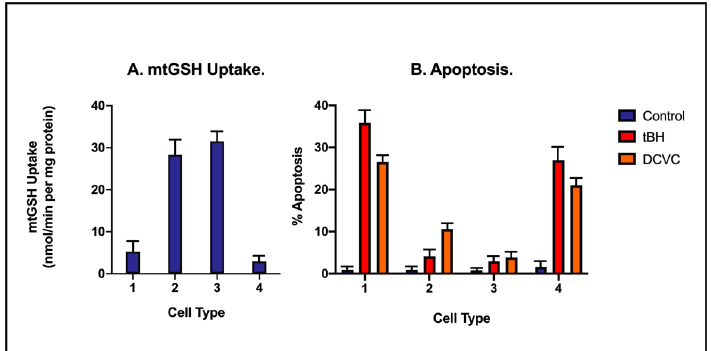
Figure 7. Impact of genetic modulation of mtGSH transporter expression in NRK-52E cells on mtGSH uptake and apoptosis caused by two mitochondrial toxicants. The cDNA for the rat kidney DIC was transiently overexpressed in NRK-52E cells (NRK-DIC = cell type 2), and the cDNA for either the normal OGC (NRK-OGC = cell type 3) and that of a double-cysteine mutant OGC with ~20% of normal activity (NRK-OGC-C221,224S = cell type 4) were stably expressed. Responses were compared to those of wild-type NRK-52E cells (=cell type 1). ( A ) Initial uptake rates for mtGSH. Mitochondria were isolated from each cell population and were incubated with [ 3 H]-GSH (final concentration = 5 mM). Data are means ± SD of initial uptake rates from 3–5 separate experiments. ( B ) Percent of apoptotic cells. The four different cell populations were incubated for 4 hr with a normal cell culture medium (=control), 10 µM tBH, or 50 µM DCVC. The percentage of cells undergoing apoptosis (sub-G 1 fraction) was estimated by propidium iodide staining, flow cytometry, and fluorescence-activated cell sorter (FACS) analysis. Results are means ± SD of 4–5 separate experiments. While the data were derived from previously published primary studies [53,54], the combined summary figure was adapted and modified from a previous review paper [35].